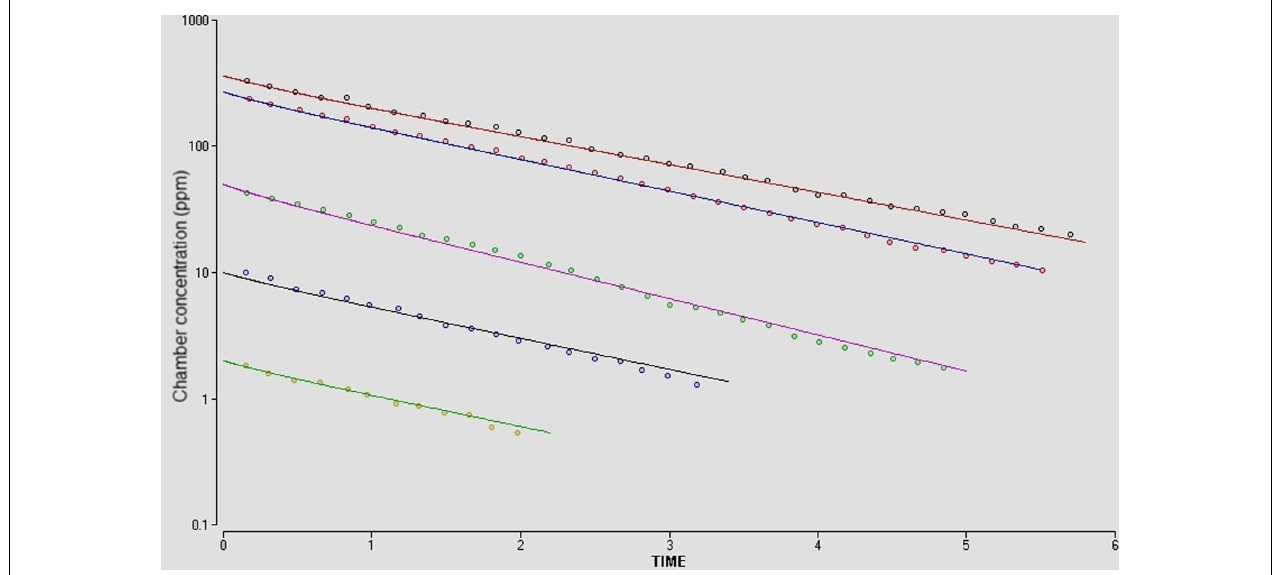
FIGURE 13 | Reproduction of Figure 2A from Himmelstein et al. (2004). In vivo closed-chamber gas uptake of β -chloroprene in the B6C3F1 mouse. Mean experimental data (symbols) and simulations (lines) represent initial concentrations of 2, 10, 50 270, or 363ppm. PBPK model exported in Berkeley Madonna syntax.